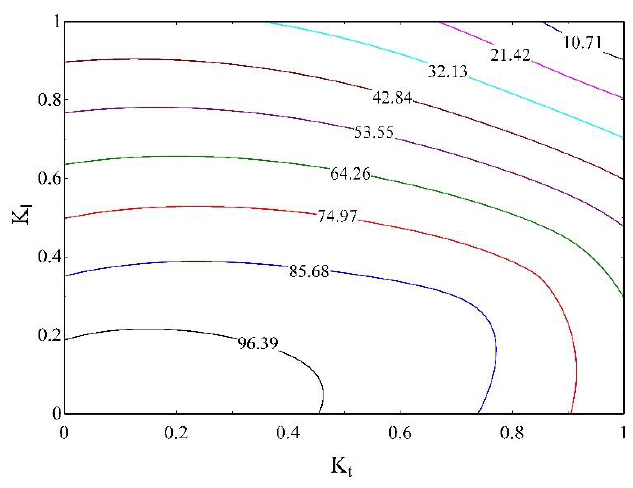
Figure 15. Average optical concentration in the receiver plane.